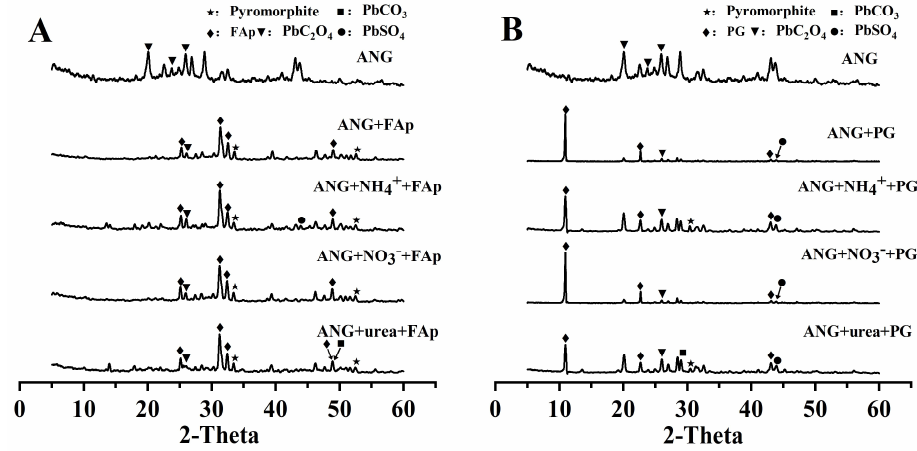
Figure 6. XRD patterns of precipitation in the FAp ( A ) and PG ( B ) treatments after six days of incu- bation.